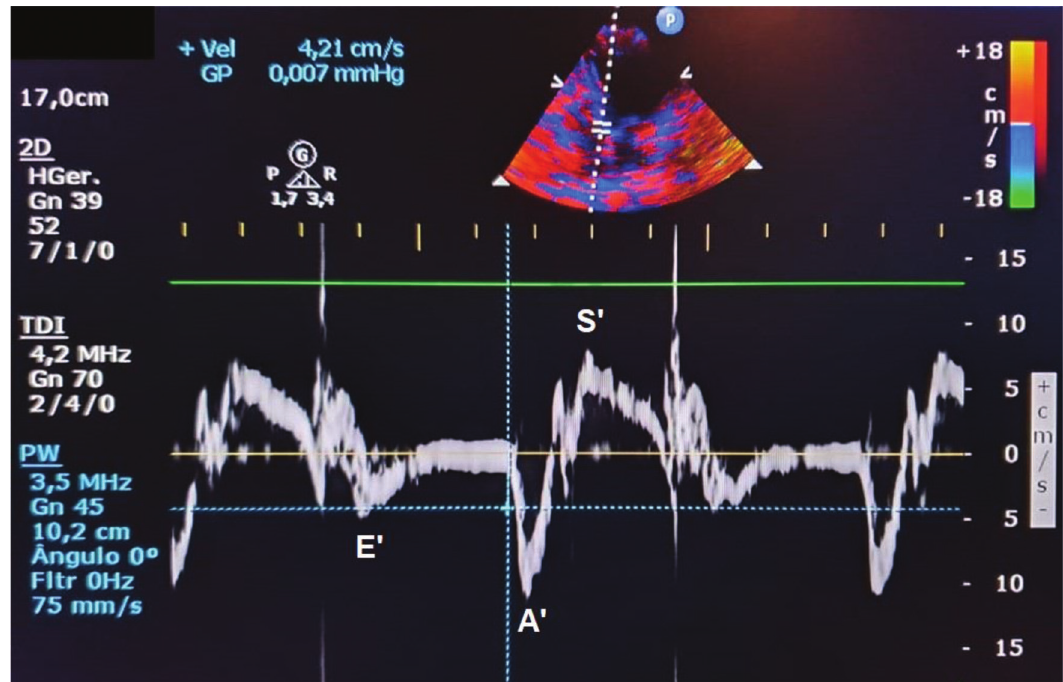
Figure 2 - Septal tissue Doppler in the apical window four-chamber view to assess the velocity of mitral annular systolic (S ’ ) and diastolic excursion in the early filling phase (E ’ ) and atrial contraction phase (A ’